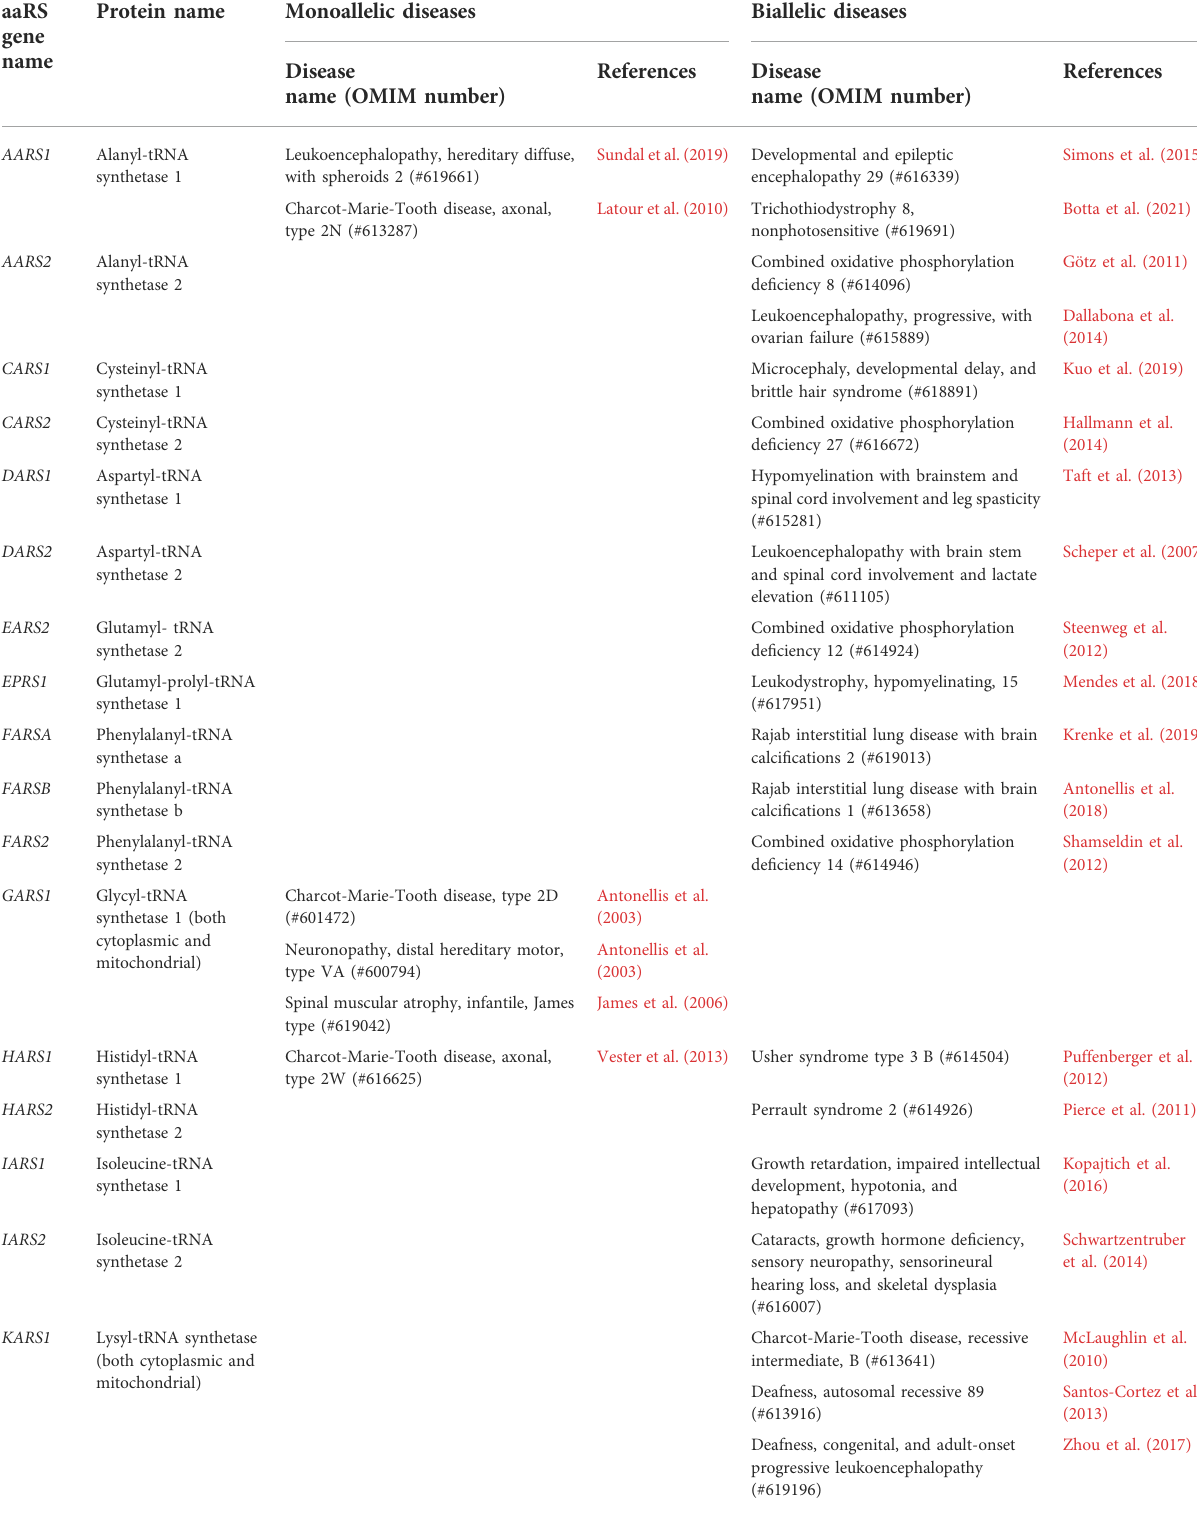
TABLE 1 Complete list of each aaRS-encoding gene and every human disease in the Online Mendelian Inheritance in Man resource (OMIM - https:// www.omim.org) caused by damaging monoallelic and biallelic variants in that